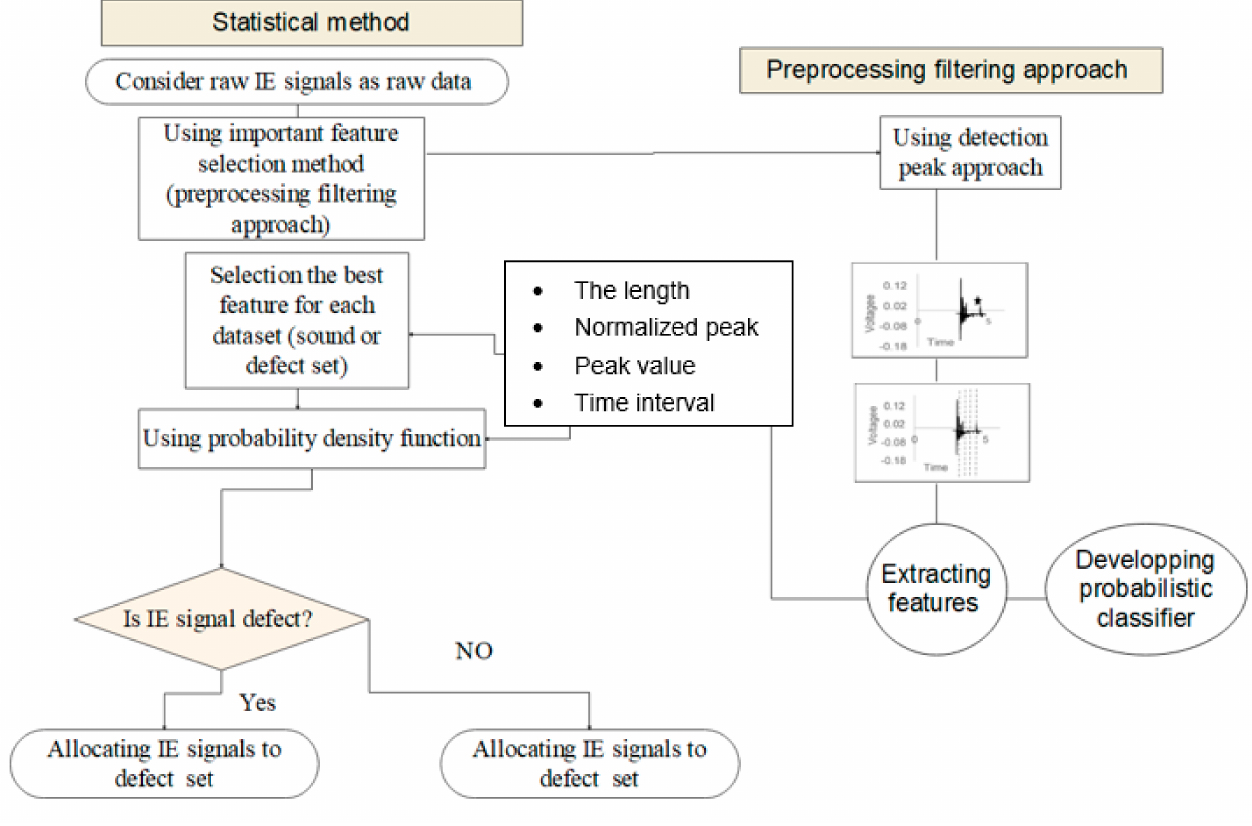
Figure 3. Description of the proposed